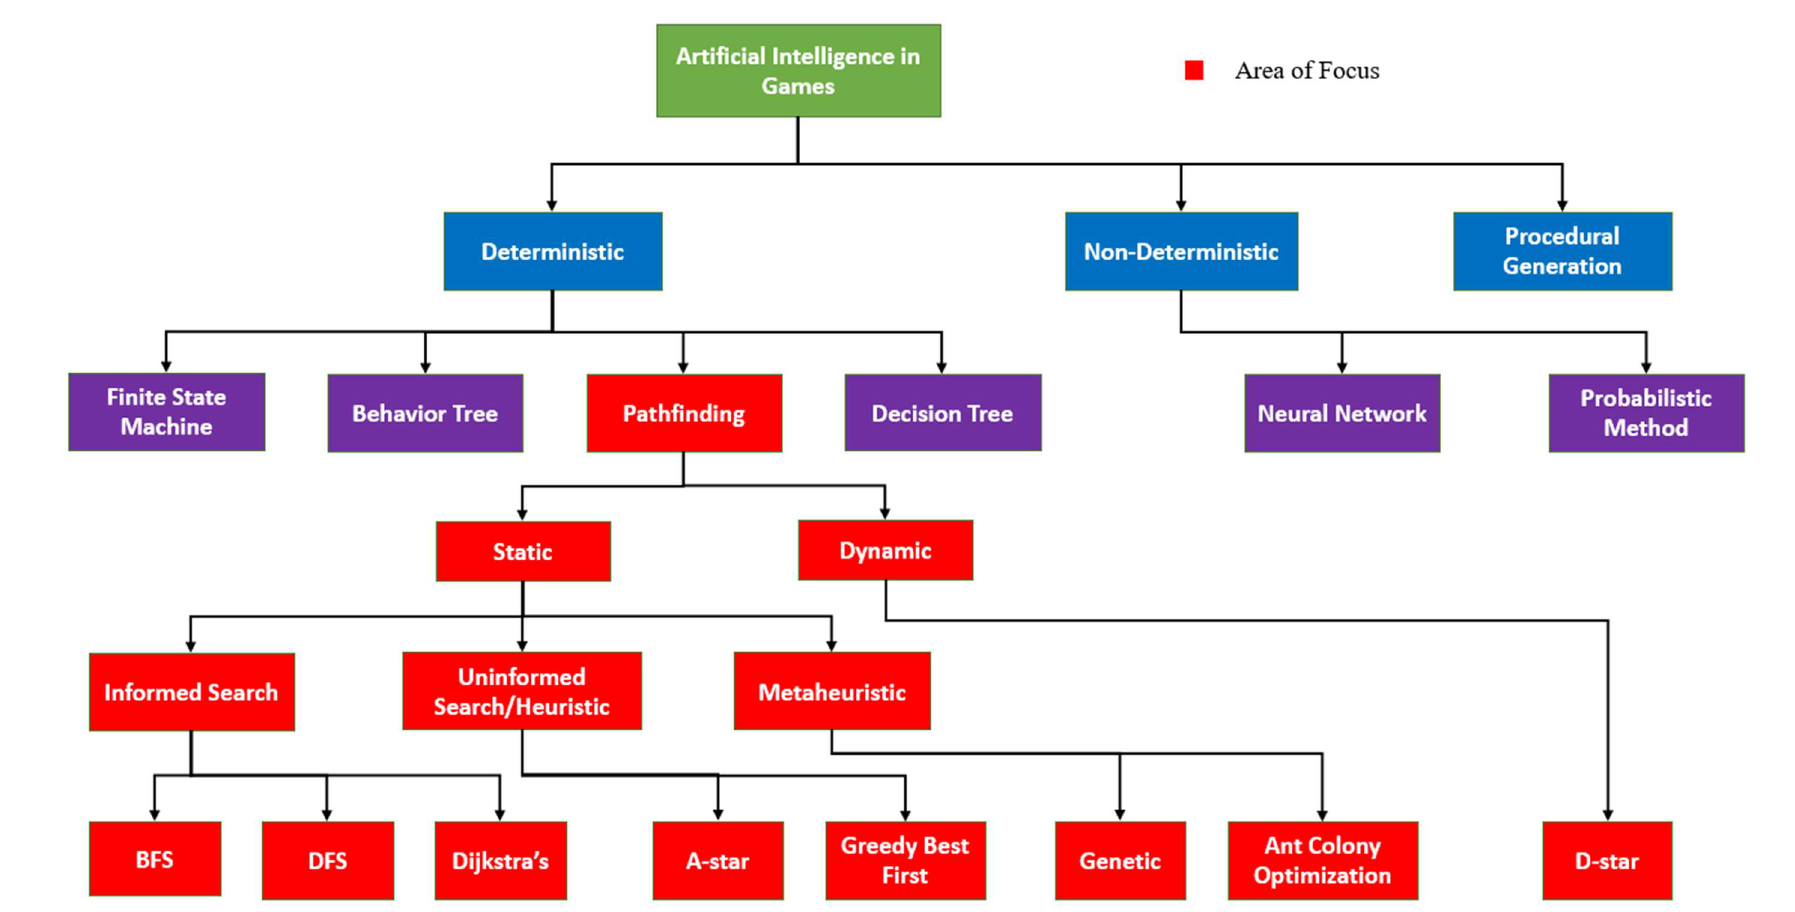
Figure 1. Classification of intelligence-based pathfinding Algorithms in gaming.